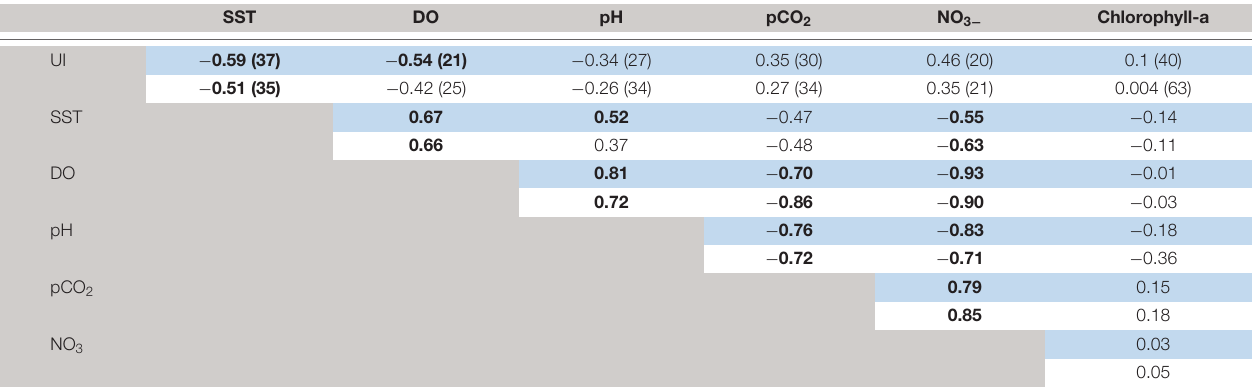
TABLE 1 | Spearman coefficient correlations of sea surface parameters collected at POSAR buoy off central Chile. SST DO pH pCO